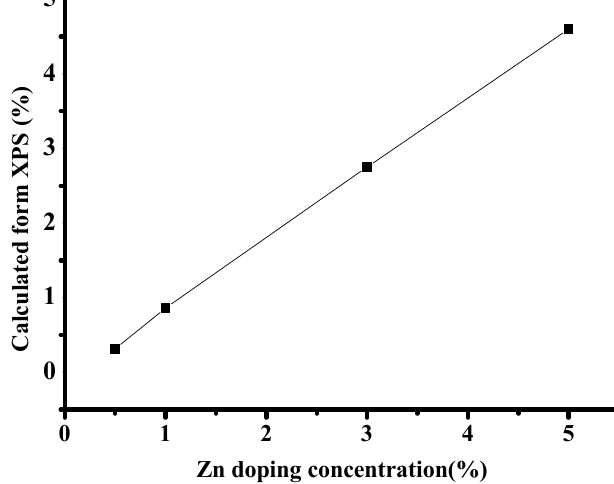
Figure 6. The surface concentration of Zn ions on the Zn–ZrO2 NPs.